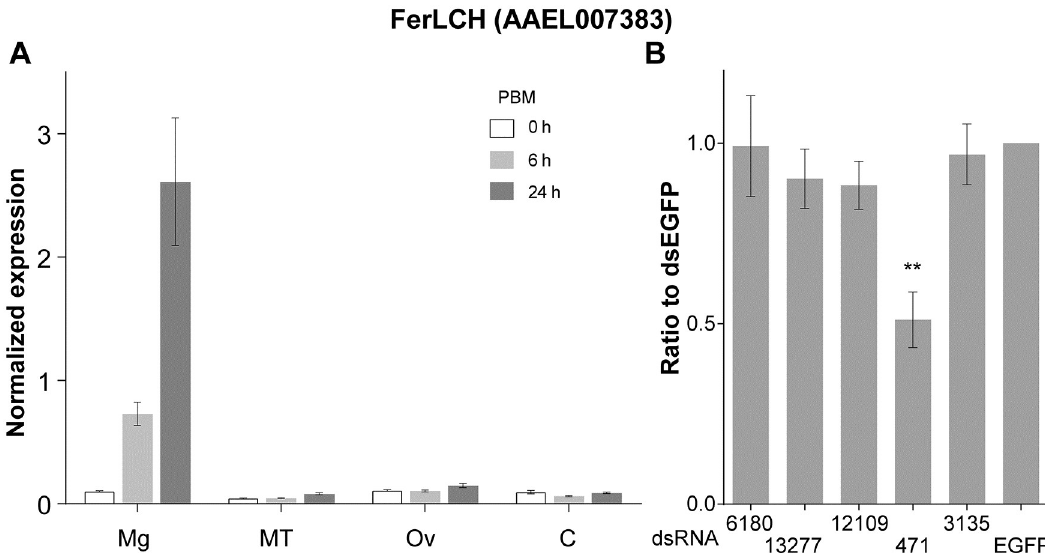
Fig 4. Ferritin light chain mRNA expression. (A) qRT-PCR quantification of transcript expression pre- and post-bloodmeal in the midgut (Mg), Malpighian tubules (MT), Ovaries (Ov) and remaining body parts (C) (mean ± SD normalized to rpS7), (B) ferritin LCH expression in Mg 24 hPBM in dsRNA-injected mosquitoes (n = 8–12) (mean ± SD of ratio to dsEGFP of rpS7 normalized expression). �� : p < 0.01 by Kruskal-Wallis test followed by multiple comparison.